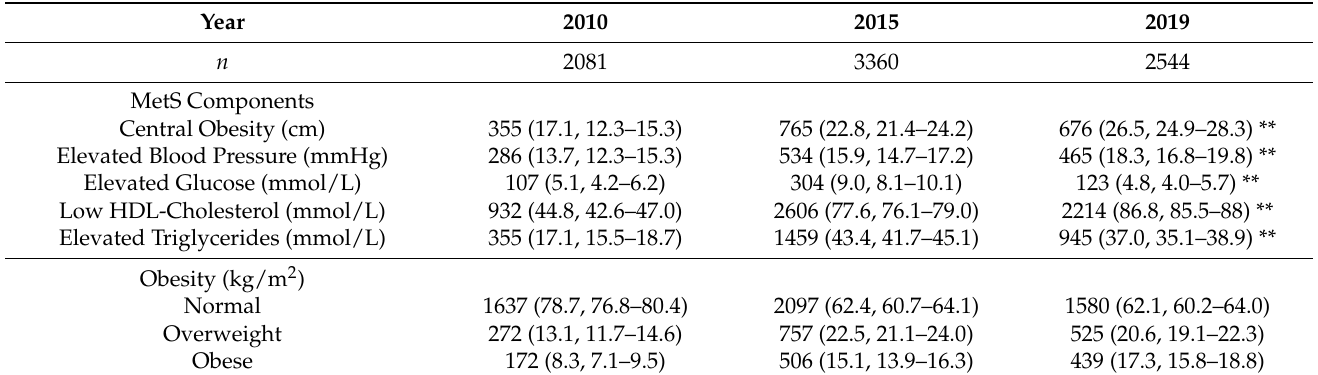
Table 3. Overall prevalence of MetS components in the 2010, 2015, and 2019 cohort.